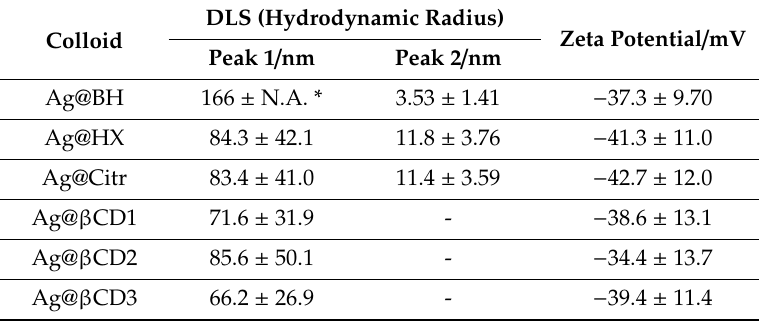
Table 1. Zeta potential and hydrodynamic radius for the synthesized AgNPs.